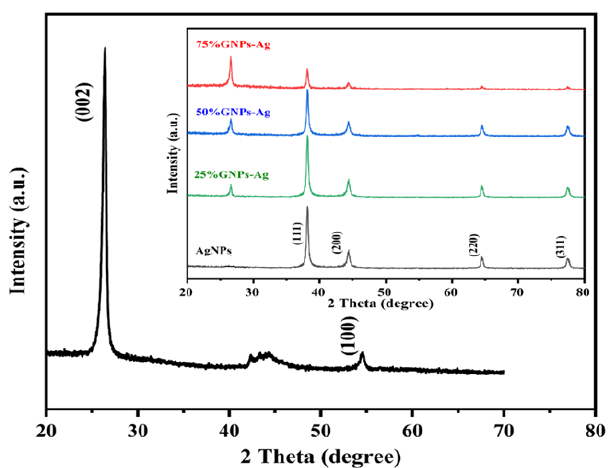
Figure 4. XRD spectral analysis of GNPs, AgNPs and Ag/G nanocomposites with varying ratios of GNPs (inset). GNPs